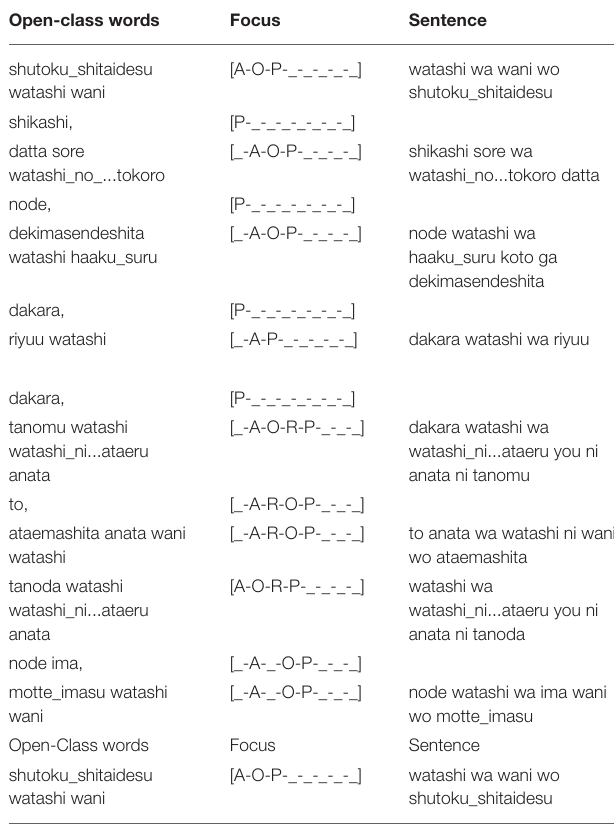
TABLE 12 | Synonyms. TABLE 13 | Automatically generated Japanese